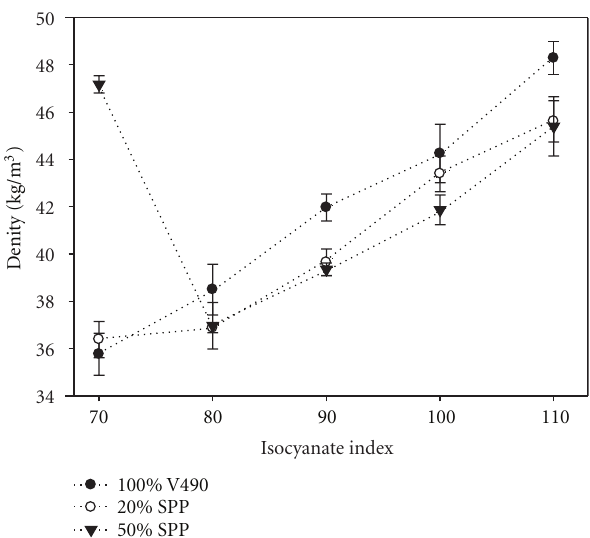
Figure 8: Results of compressive strength versus isocyanatye den-